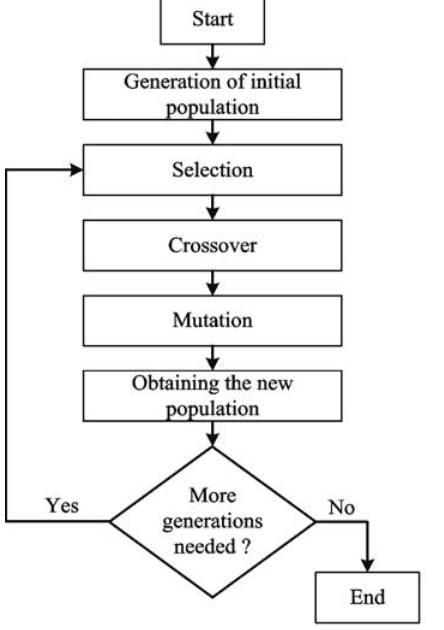
Fig. 7. Scheme of classical genetic algorithm